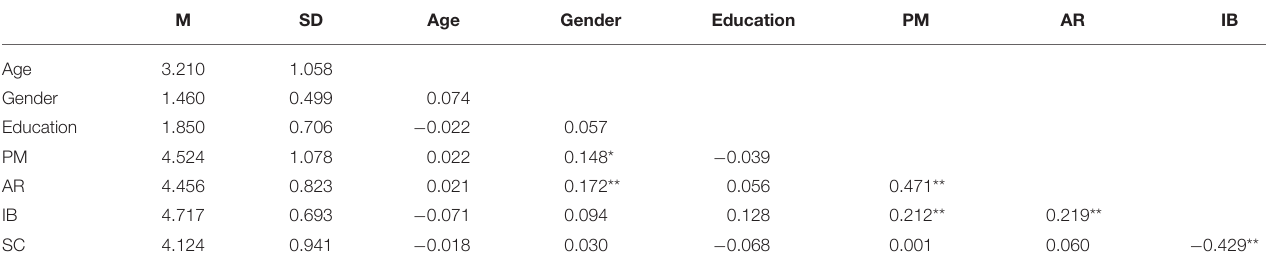
TABLE 3 | Descriptive statistics and correlation analysis of variables.